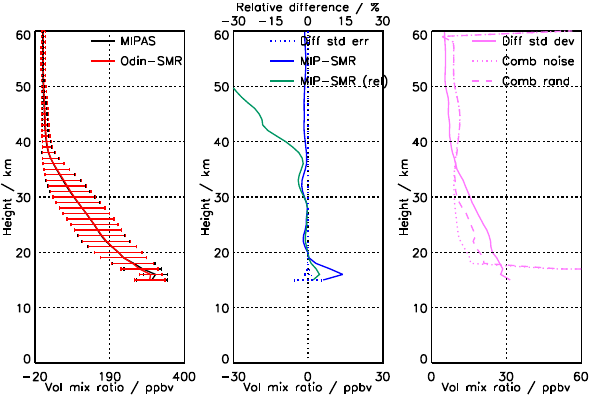
Figure 14. Comparison of N 2 O from Odin-SMR and MIPAS full resolution (V5H_N2O_21). Details as in Fig. 1.